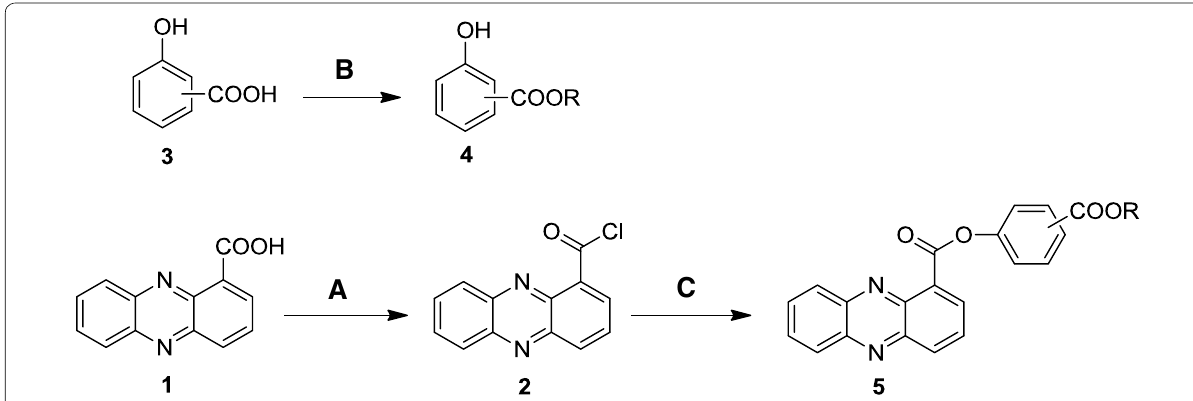
Fig. 3 Synthetic route of target compounds. Reagents and conditions: a oxalyl chloride, CH 2 Cl 2 , DMF, reflux, 8 h; b alcohol, reflux, overnight; c hydroxybenzoic acid ester, CH